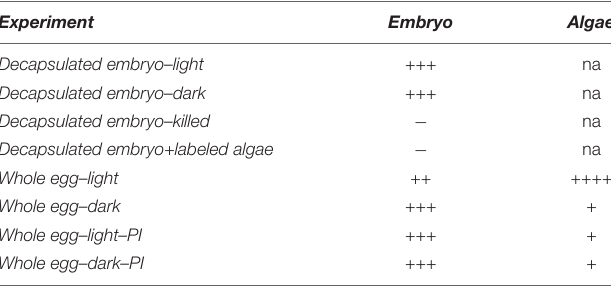
TABLE 1 | Results